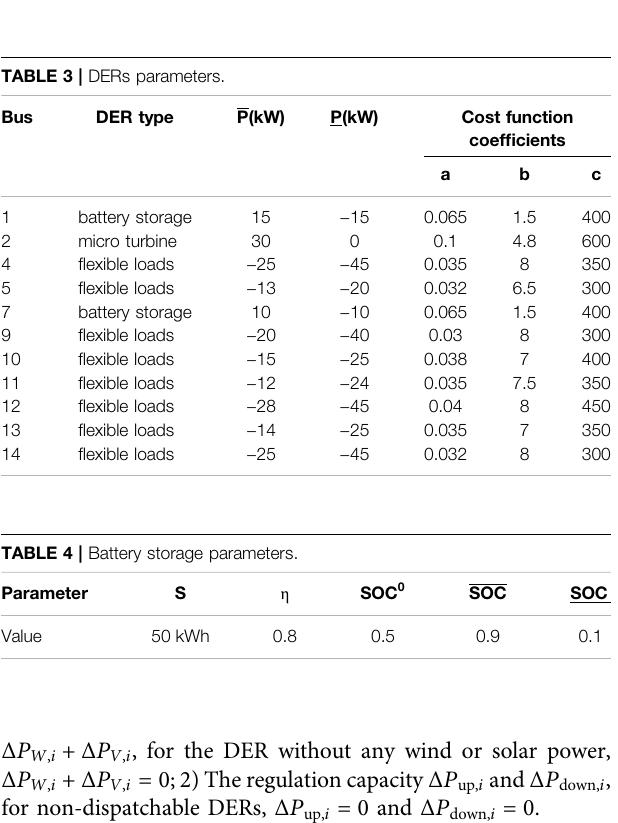
FIGURE 3 | Diagram of the 14-DERs VPP.